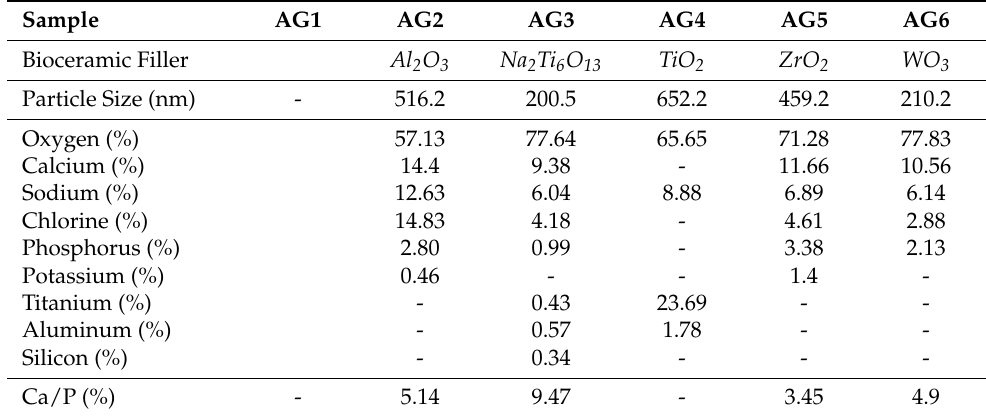
Table 2. Size from bioceramics used for this comparative study and EDAX